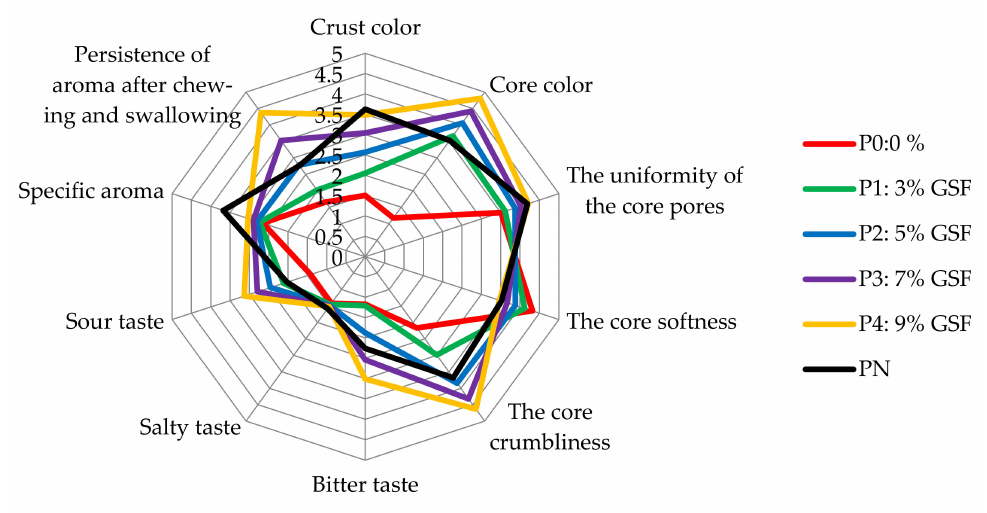
Figure 3. Results of sensory analysis of bread samples with the addition of